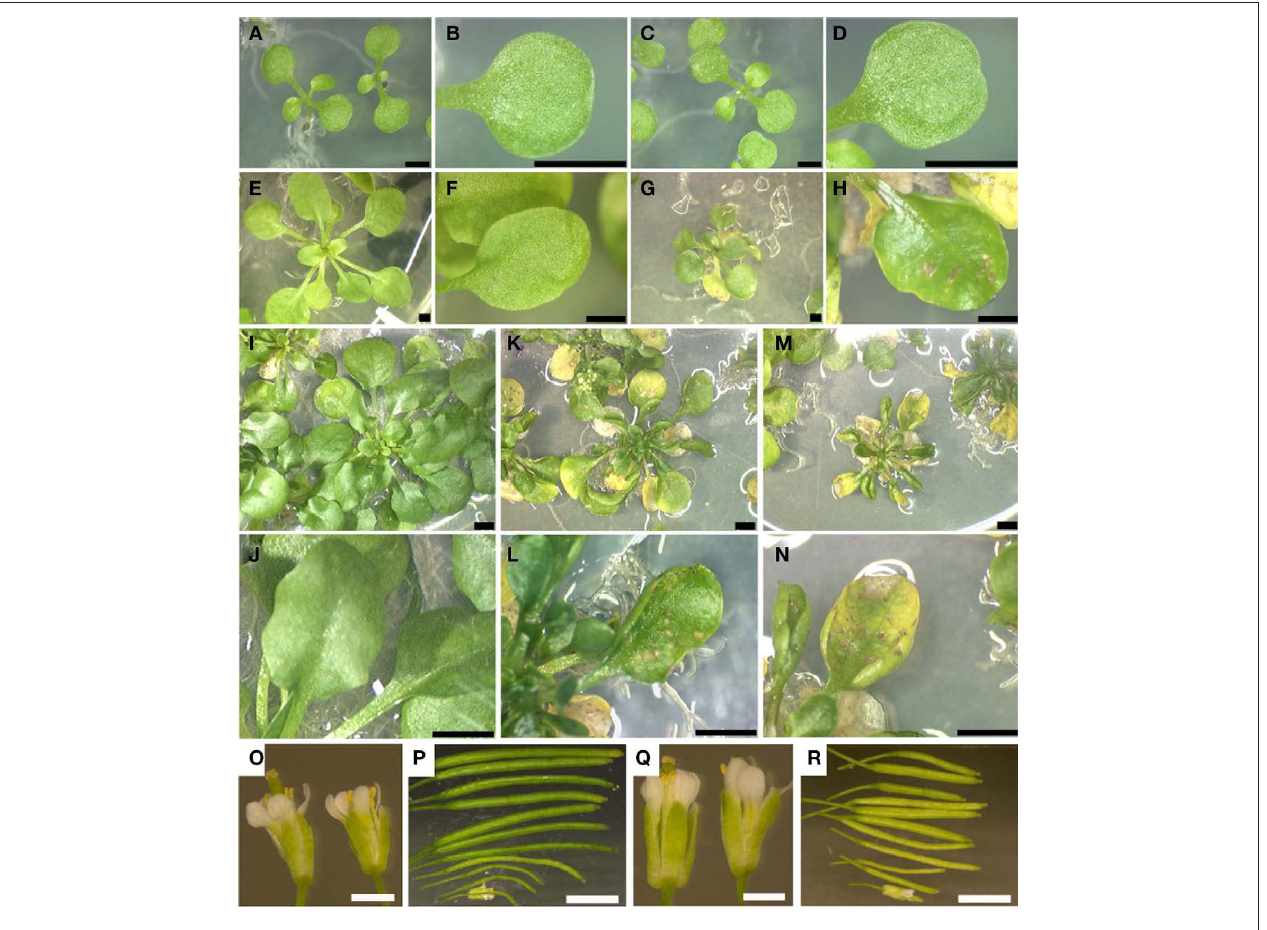
FIgURe 5 | Phenotype of wild-type and sns-D mutant plants and development of necrotic spots on the leaves. Leaves and cotyledons of 1-week-old wild-type (A,B) and sns-D (C,D) seedlings, 3-week-old wild-type (e,F) and sns-D (g,H) seedlings, and 5-week-old wild-type (I,J) and sns-D (K–N)